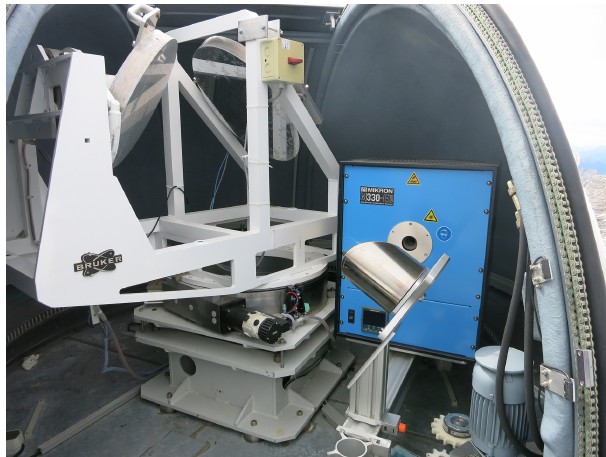
Figure 1. Blackbody calibration source inside the Zugspitze solar FTIR dome, additional 90 ◦ off-axis mirror and solar